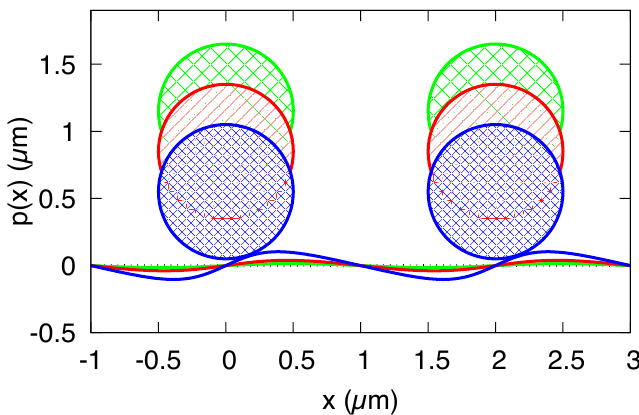
Figure 5. In the sequence red to green to blue, an array of precipitates approaches an originally planar grain boundary and leads to an increasing morphological change p ( x ) (cid:54) = 0. The parameters are d blue = 0.55 µ m, d red = 0.85 µ m, d green = 1.15 µ m, E = 175 GPa, ν = 0.25, R = 0.5 µ m, W = 20.55 µ m, β = 0.07, and eigenstrain ε 0 = 0.02 between the precipitate and matrix